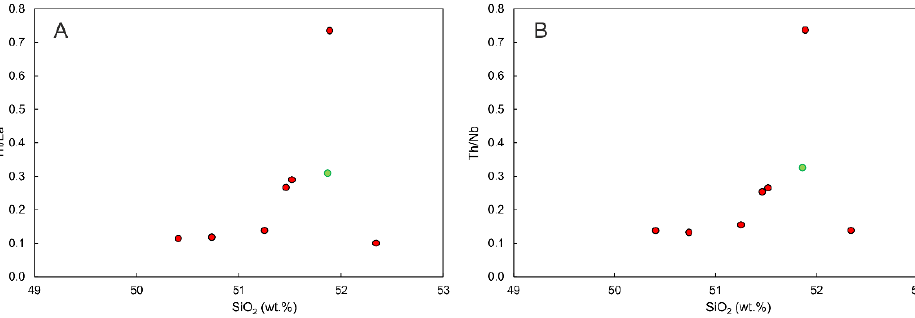
Figure 7. Trace element ratios versus SiO 2 for pillow basalts and the isotropic gabbro. ( A ) SiO 2 vs Th/La and ( B ) SiO 2 vs Th/Nb.